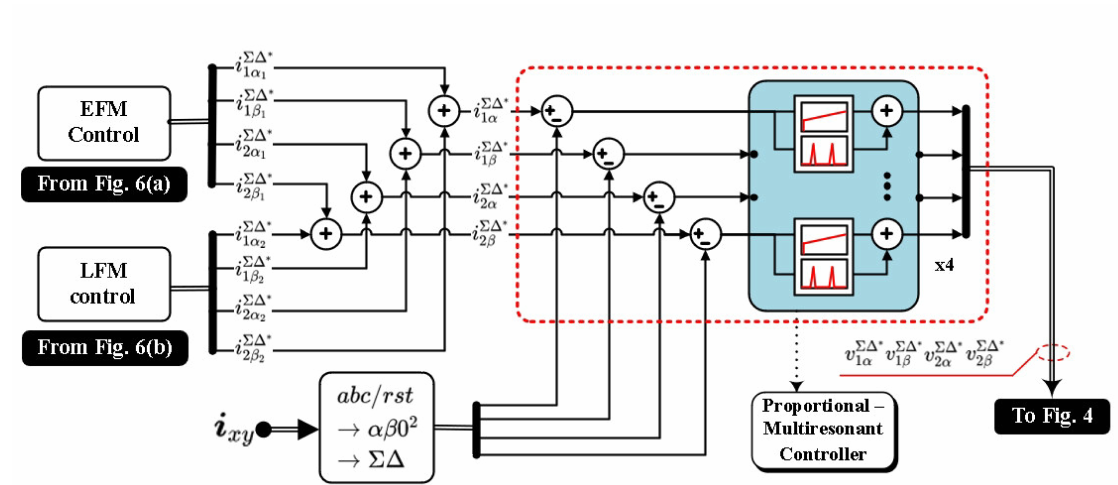
Figure 7. Proposed proportional resonant control system for the circulating